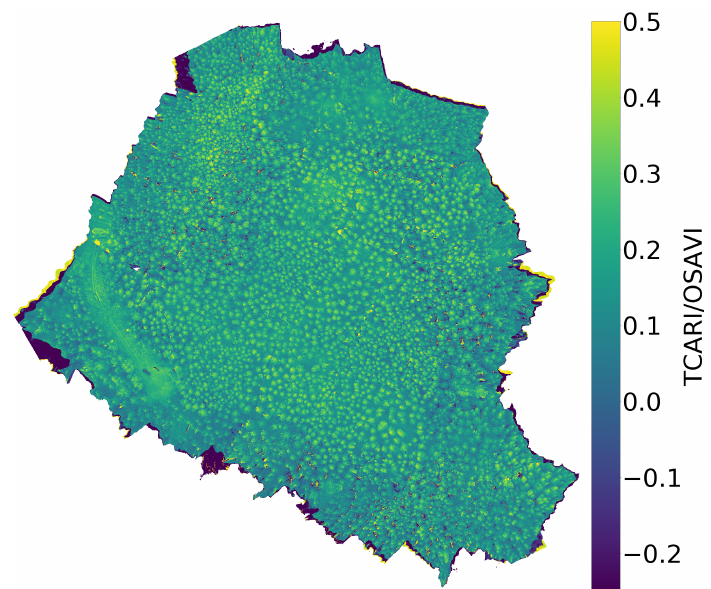
Figure 7. The chlorophyll a (top), b (middle), and TCARI are calculated by feeding the hyperspectral data to the inverse SLOP model.